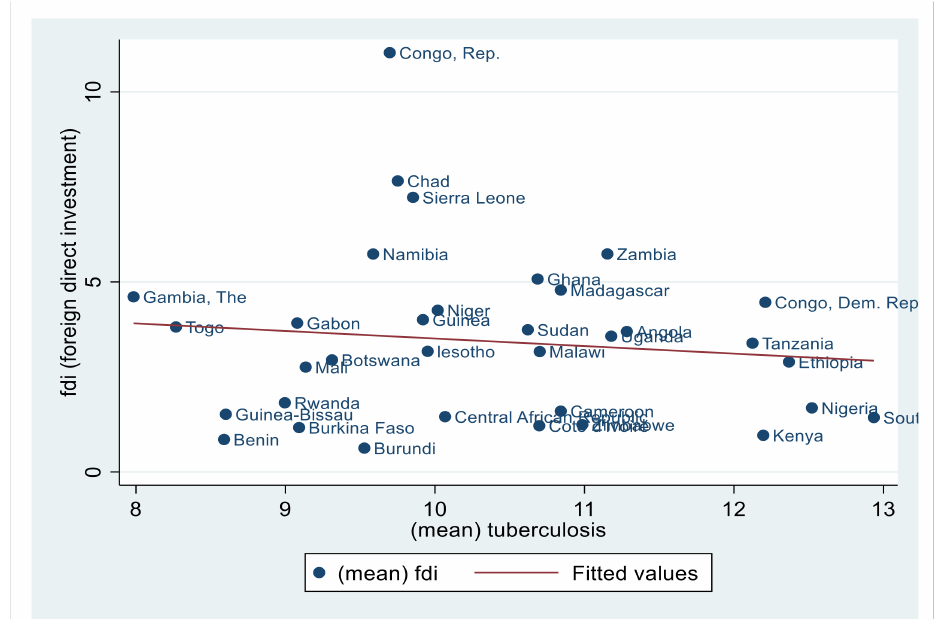
Figure 5. Tuberculosis and